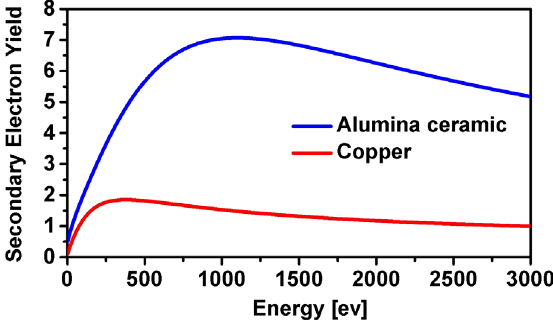
FIG. 13. Secondary electron yield curves for copper of the coaxial line and ceramic of the windows.